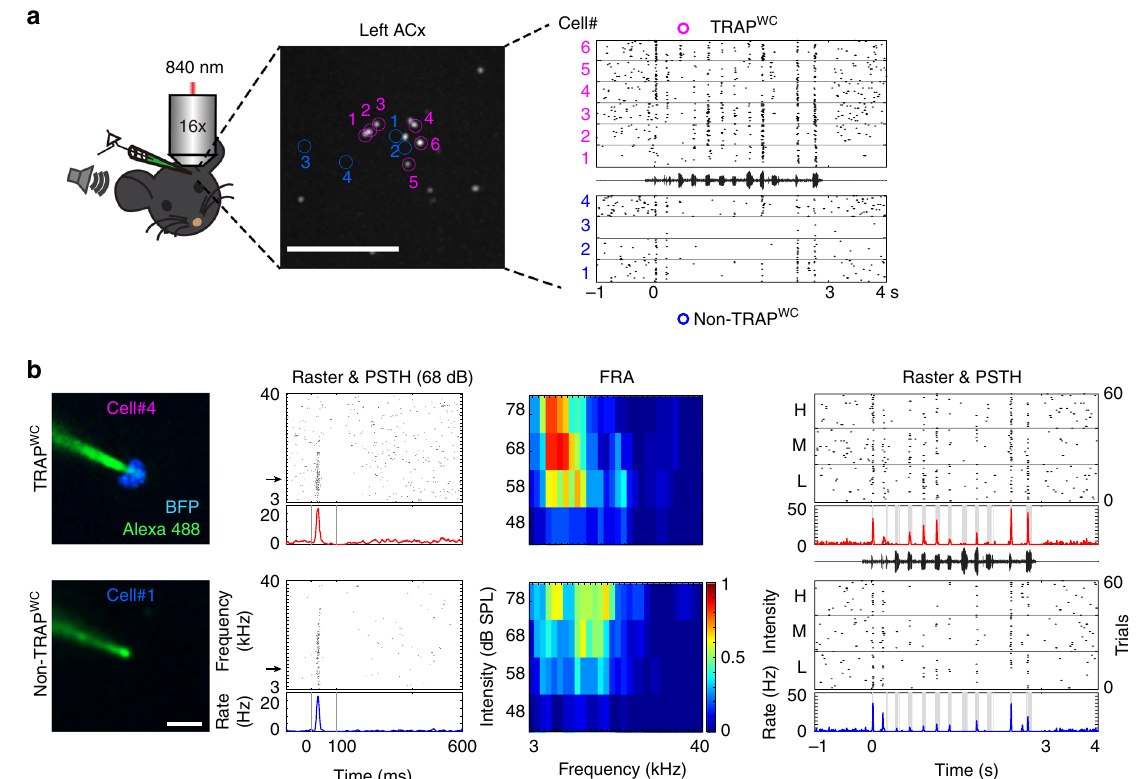
Fig. 2 In vivo electrophysiological characterization of genetic TRAPing. a Left: Schematic representation of the experimental set up for in vivo two-photon targeted recording. Middle: A representative two-photon micrograph of BFP-positive neurons from the left auditory cortex (projection of 100 – 400 μ m under the surface of A1). Scale bar 200 μ m. The 6 recorded TRAPed cells and 4 non-TRAPed cells are indicated in magenta and blue, respectively. Right: Raster plots of these 10 neurons in response to WC stimuli. b Left, representative two-photon micrographs from two neurons whose numbers correspond to the location shown in ( a ) (Green (Alexa488), electrode; Blue (BFP), TRAPed neuron). Scale bar, 10 μ m. For each neuron we recorded its responses to pure tones at 4 intensities (middle panels) and to WCs at 3 intensities (right). Rasters in response to pure tones are shown at 68 dB SPL only. Arrows in frequency axis indicate best frequency (BF) in each cell. Frequency response area (FRA) shows mean responses across all frequencies and attenuations. Color bar indicates normalized spike count. WC responses are shown at high, medium and low intensities (H, M, L; 20 trials per